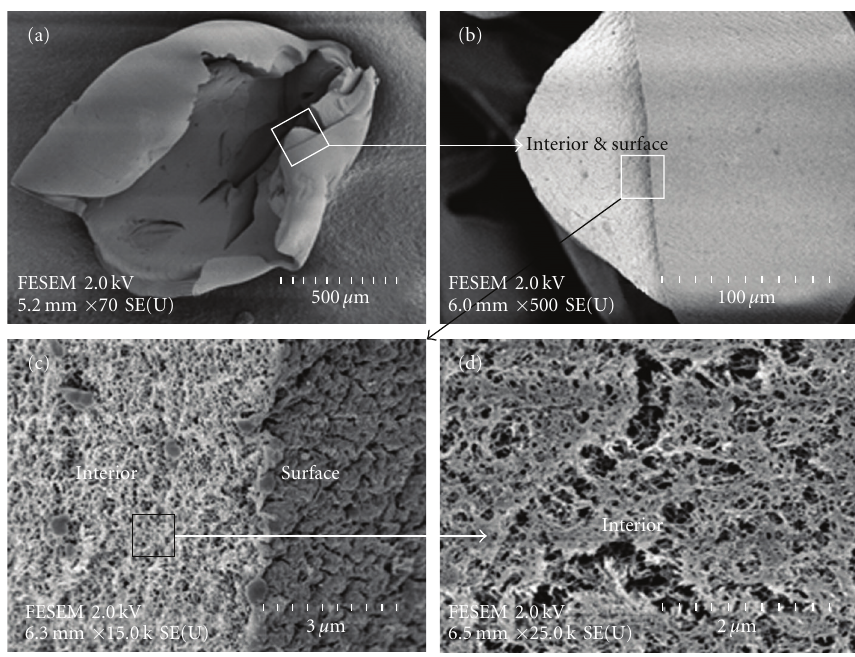
Figure 2: SEM images of the surface and interior structure of the AC microcapsules. (a): overview at 70 × ; (b): white square in (a) at a higher magnification at 500 × ; (c): square in (b) at 15kx; and (d): square in (c) at 25 kx.